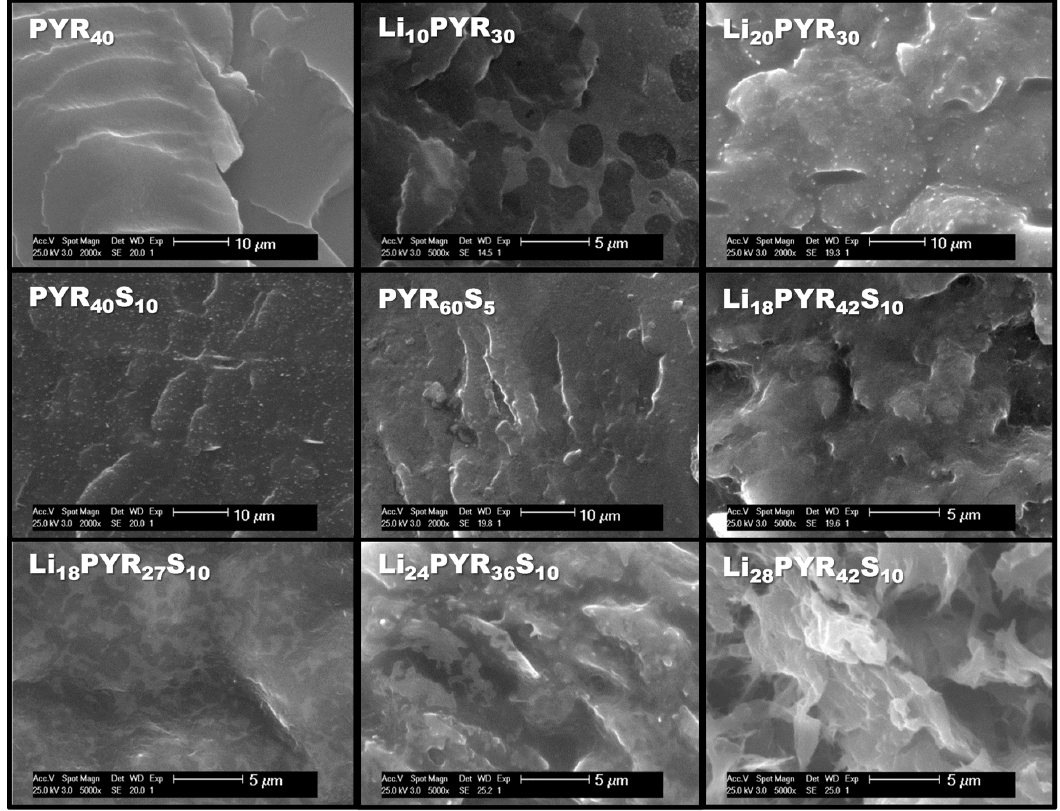
Figure 1. SEM images of all the samples in Table 1.